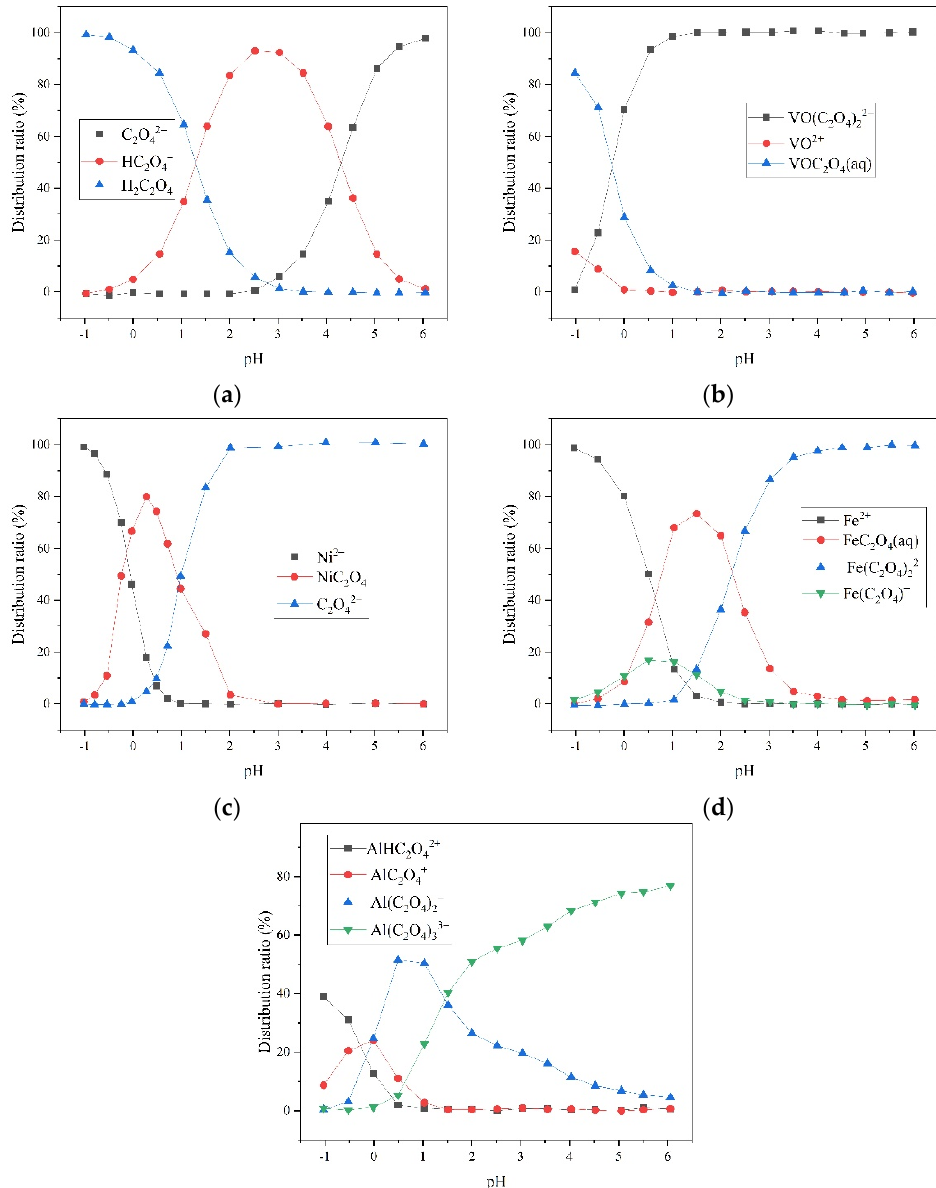
Figure 8. ( a ) Occurrence states of pure oxalic acid leaching solution, ( b ) V occupancy states in the oxalic acid leaching solution, ( c ) Ni occupancy states in the oxalic acid leaching solution, ( d ) Fe occupancy states in the oxalic acid leaching solution, ( e ) Al occupancy states in the oxalic acid leaching solution.